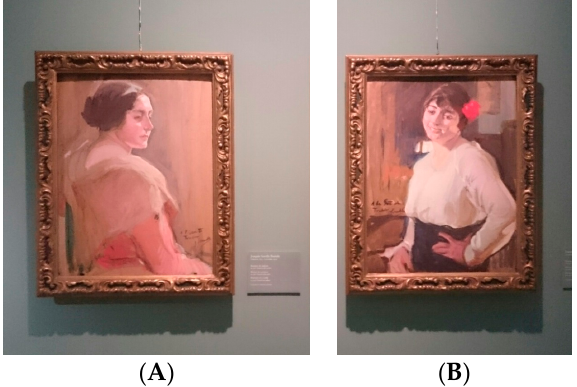
Figure 1. Portraits by Joaquín Sorolla (1863–1923), painted in 1916 with the technique of gouache on cardboard. Painting ( A ), on the left, is titled “Portrait of Madame” and painting ( B ), on the right, is “Portrait of a lady with a red flower in her hair”.